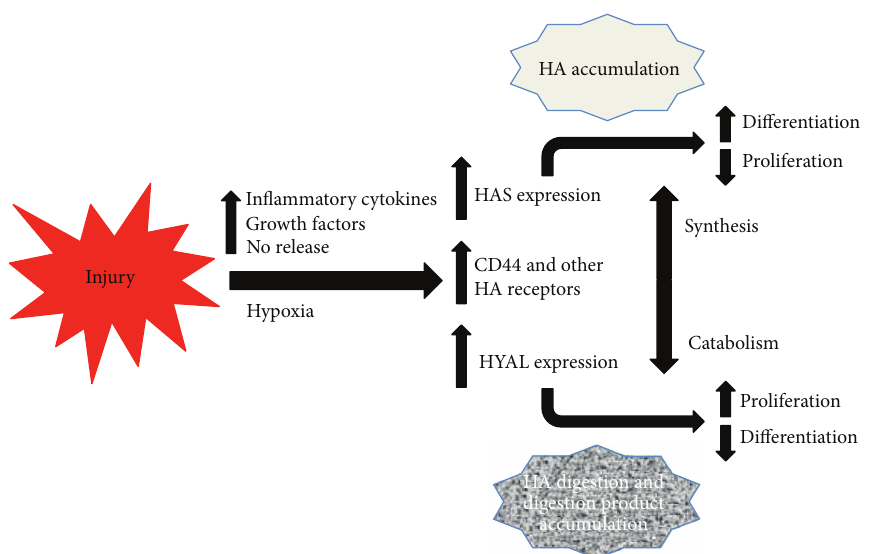
Figure 2: HA synthases, HA receptors, and hyaluronidases are transcriptionally upregulated in response to injury by inflammatory mediators and other injury-induced mediators. As a result, HA increases in injured tissues but also is digested. The balance between HA synthesis and catabolism influences cellular behaviors, such as proliferation and differentiation, either by influencing signals induced by high molecular weight HA or due to the accumulation of HA digestion products that have their own biological